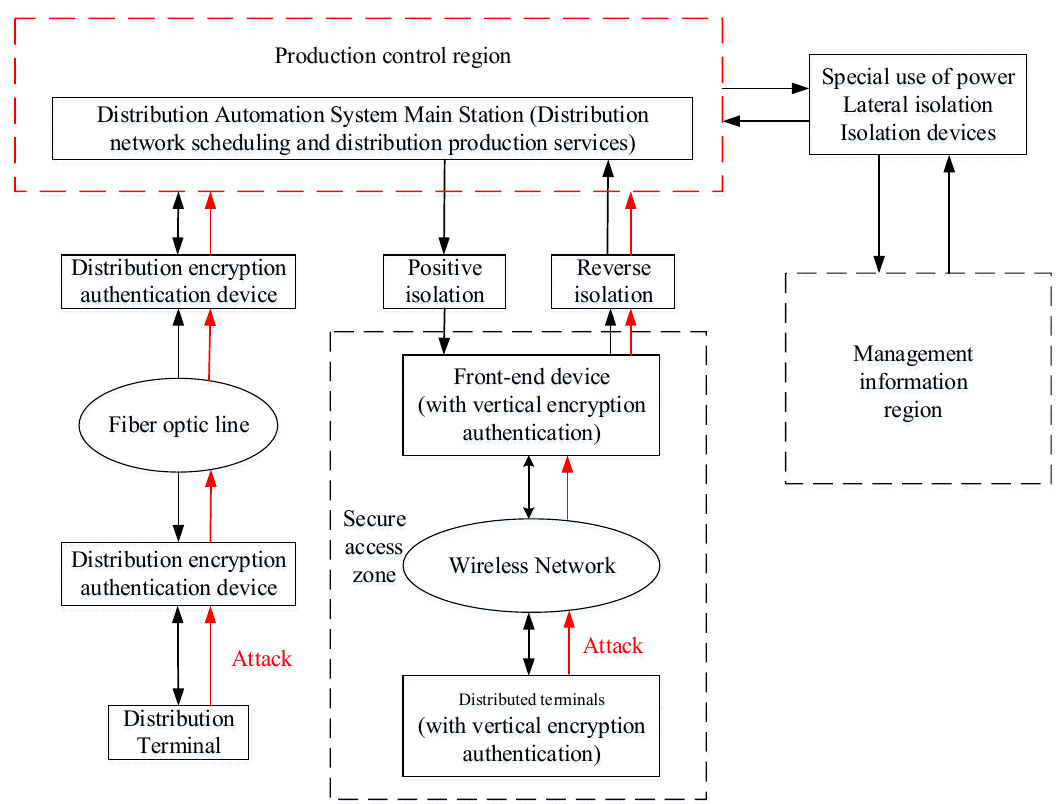
Figure 1. Distribution automation system (DAS) security architecture.